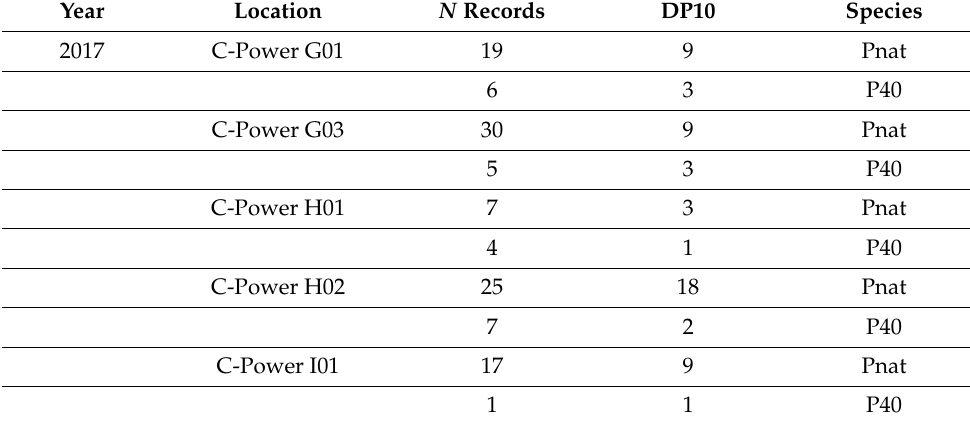
Table 1. Number of records and detection positive ten minutes (DP10) per species for each survey location. Each location in the C-Power wind farm represents a turbine with its unique name. Pnat: Pipistrellus nathusii ; Ppip: P. pipistrellus ; P40: P. nathusii / P. pipistrellus / P. kuhlii